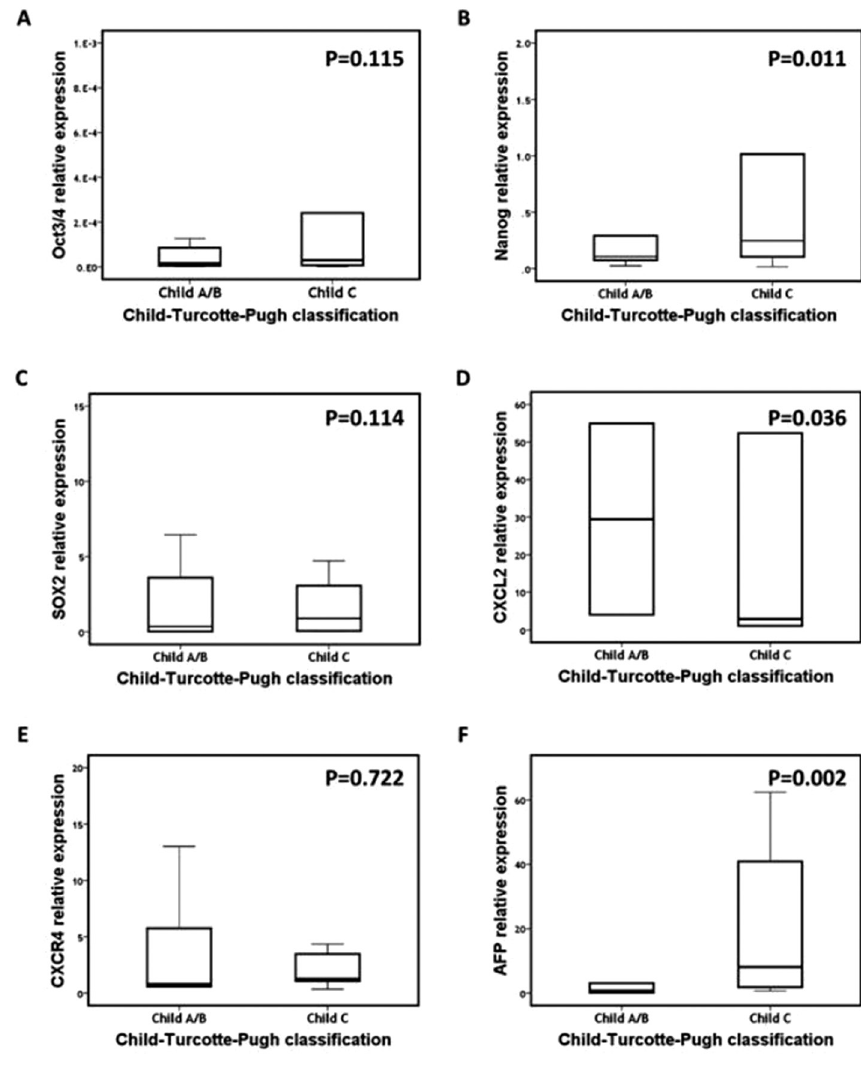
Figure 2. Association between gene expression and clinical characteristics. Child- Turcotte-Pugh classification was used for prognostic scoring in patients with liver disease. Mann Whitney U test was used. Statistical significance at p <